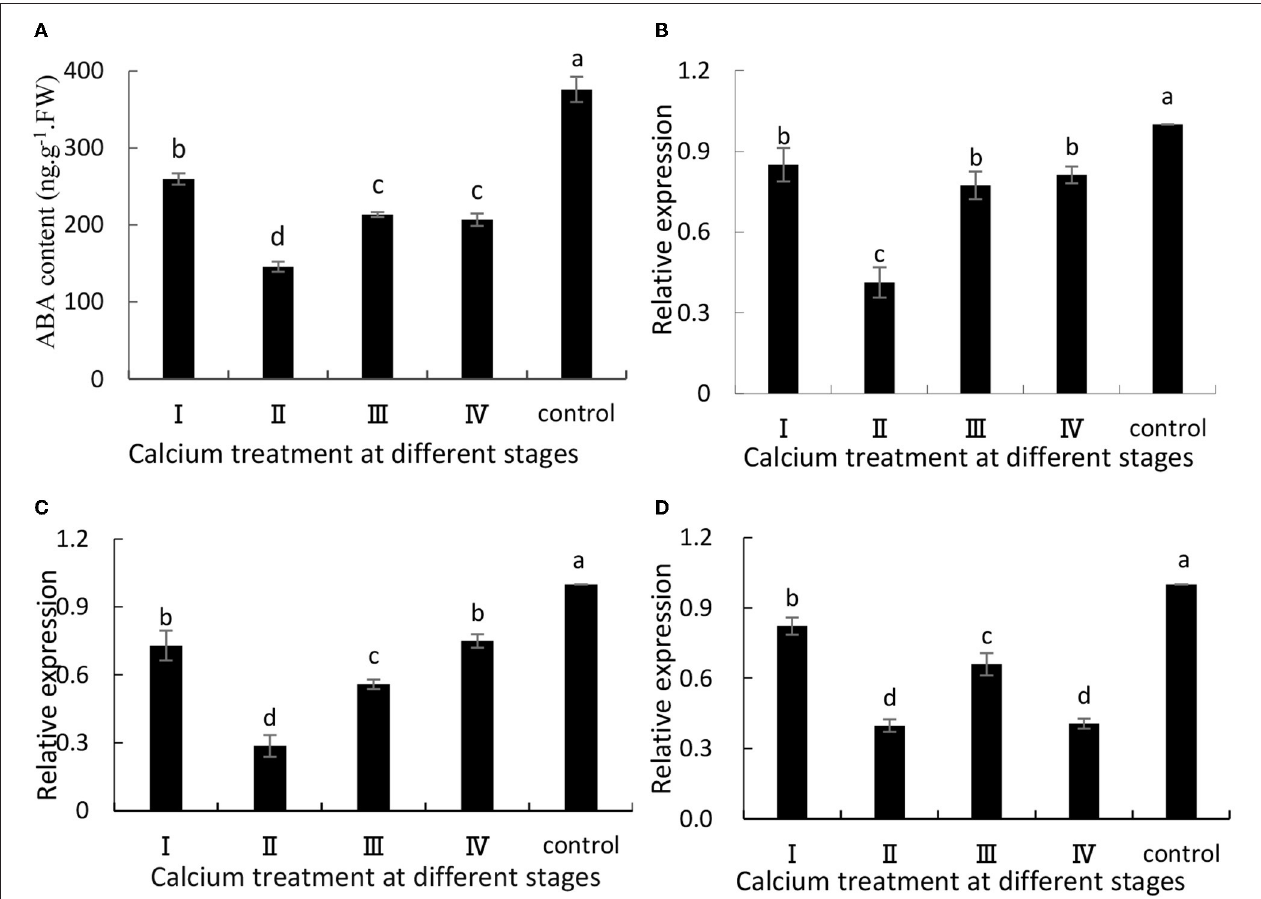
FIGURE 1 | (A) ABA content, and expression of (B) VvNCED1, (C) VvCYP707A1, and (D) VvBG1. Data are presented as mean ± standard. Lowercase letters represent significant differences ( P <